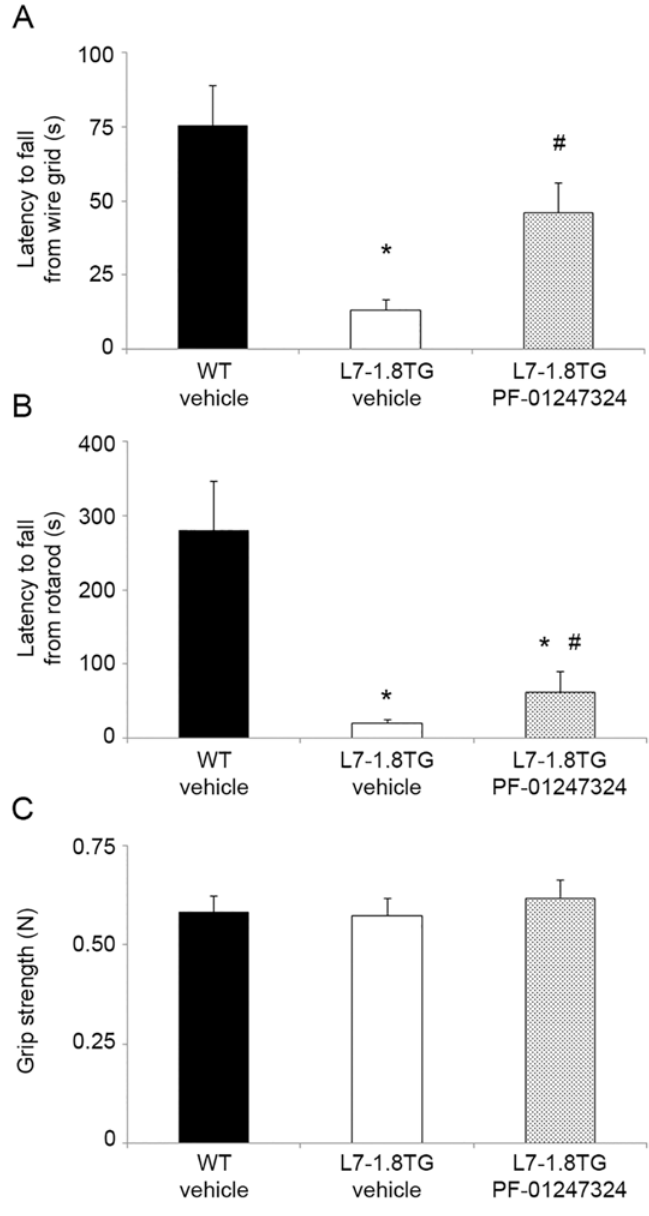
Fig 1. Oral administration of PF-01247324 partially reverses motor incoordination in transgenic mice overexpressing Nav1.8 in cerebellar Purkinje neurons. A . Latency to fall from an inverted wire grid was measured in L7 – 1.8TG mice administered either PF-01247324 or vehicle, and in their wildtype littermates. Behavioral testing was performed one hour after dosing. Differences between the three groups were significant (one-way ANOVA, p = 0.0014). L7 – 1.8TG mice in the vehicle group performed significantly worse than WT mice. L7 – 1.8TG mice that received oral dosing of PF-01247324 had significantly improved performance in this assay. B . In the rotarod test, significant differences in motor coordination were observed (one-way ANOVA, p = 0.0006). L7 – 1.8TG mice in the vehicle group were able to stay on the rotating beam for less time than WT mice, indicating a deficit in motor coordination. Oral administration of PF-01247324 to L7 – 1.8TG mice significantly improved their performance compared to vehicle-treated mice of the same genotype. C . Grip strength was similar in each of the three groups. One-way ANOVA, p = 0.7560. * , p < 0.05 compared to WT vehicle group; #, p < 0.05 compared to L7 – 1.8TG vehicle group, Dunnett ’ s post-hoc test. WT +vehicle, n = 8; L7 – 1.8TG+vehicle, n = 7; L7 – 1.8TG+PF-01247324, n =